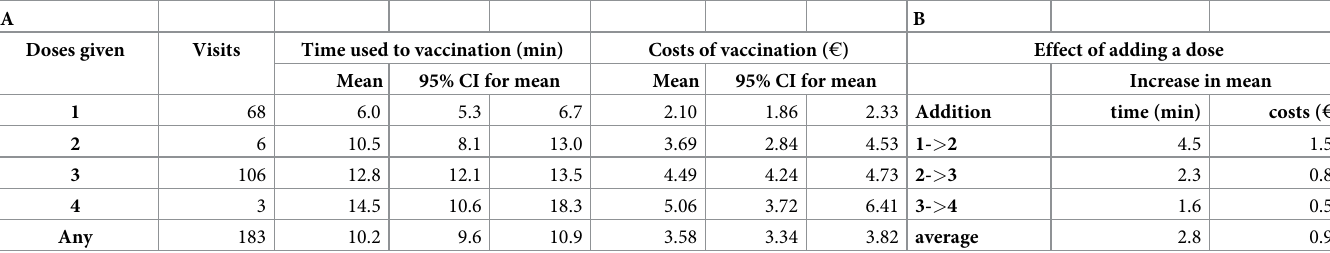
Table 4. The time and cost used for vaccination (A) and the effect of adding a vaccination dose to visit (B). A B Doses